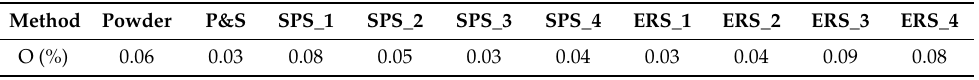
Table 4. Oxygen content (wt.%) of FeCrCoNiAl 1.8 Cu 0.5 sintered by P&S, SPS, and ERS.